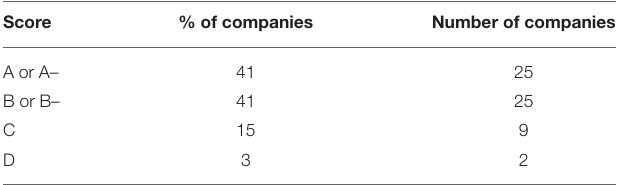
TABLE 1 | Breakdown of CDP scores of 61 companies based on submitted CDP reports.